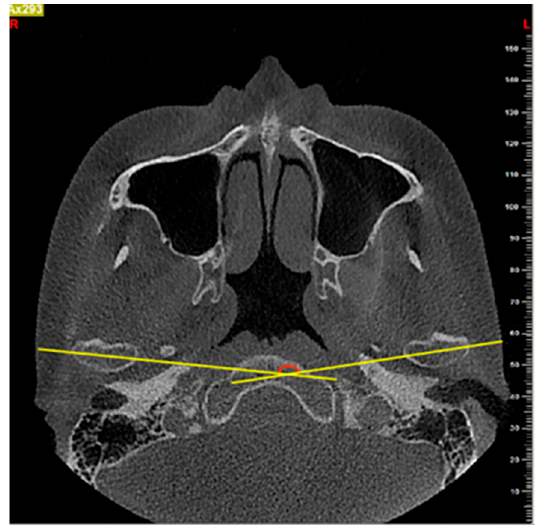
Figure 2. The measurement of intercondylar angle (IA) on the axial slice. The angle between the long axis of the left and right condyle (yellow line) was measured.